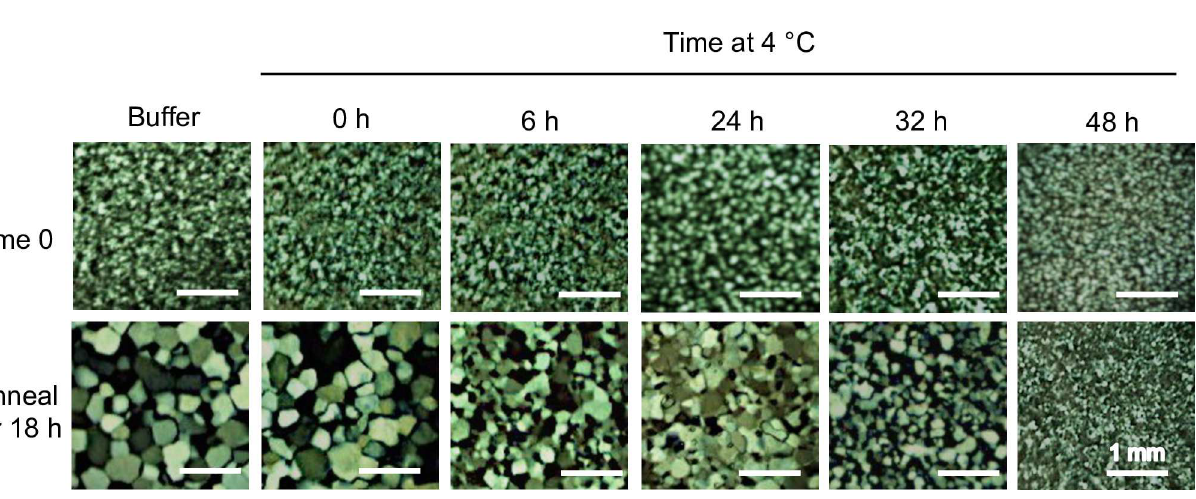
Fig 3. Assessment of ice-binding activity induction in wild-type B . distachyon . Crude lysates (0.1 mg/mL of total protein) collected from the leaves of B . distachyon were used to test for IRI activity over a 48 h cold acclimationperiodat 4˚C. Ice crystals were observedat time zero and after annealingat − 4˚C for 18 h. Assays were done in